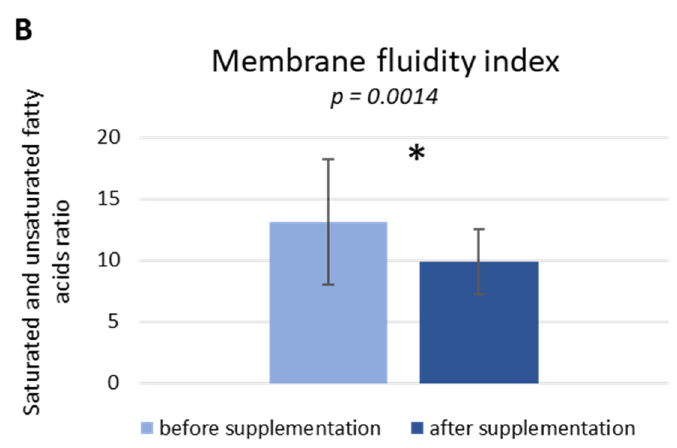
Figure 4. Omega-3 index ( A ) and membrane fluidity index ( B ) in study participants before and after 6 weeks of SLO supplementation. Data are represented as media ± SD in 25 subjects in the case of the omega-3 index and in 27 subjects in the case of membrane fluidity index. Statistical analysis was performed by Wilcoxon matched-pairs signed rank test (omega-3 index) and paired Student’s t-test (membrane fluidity index). (* p < 0.05) was considered to be statistically significant.